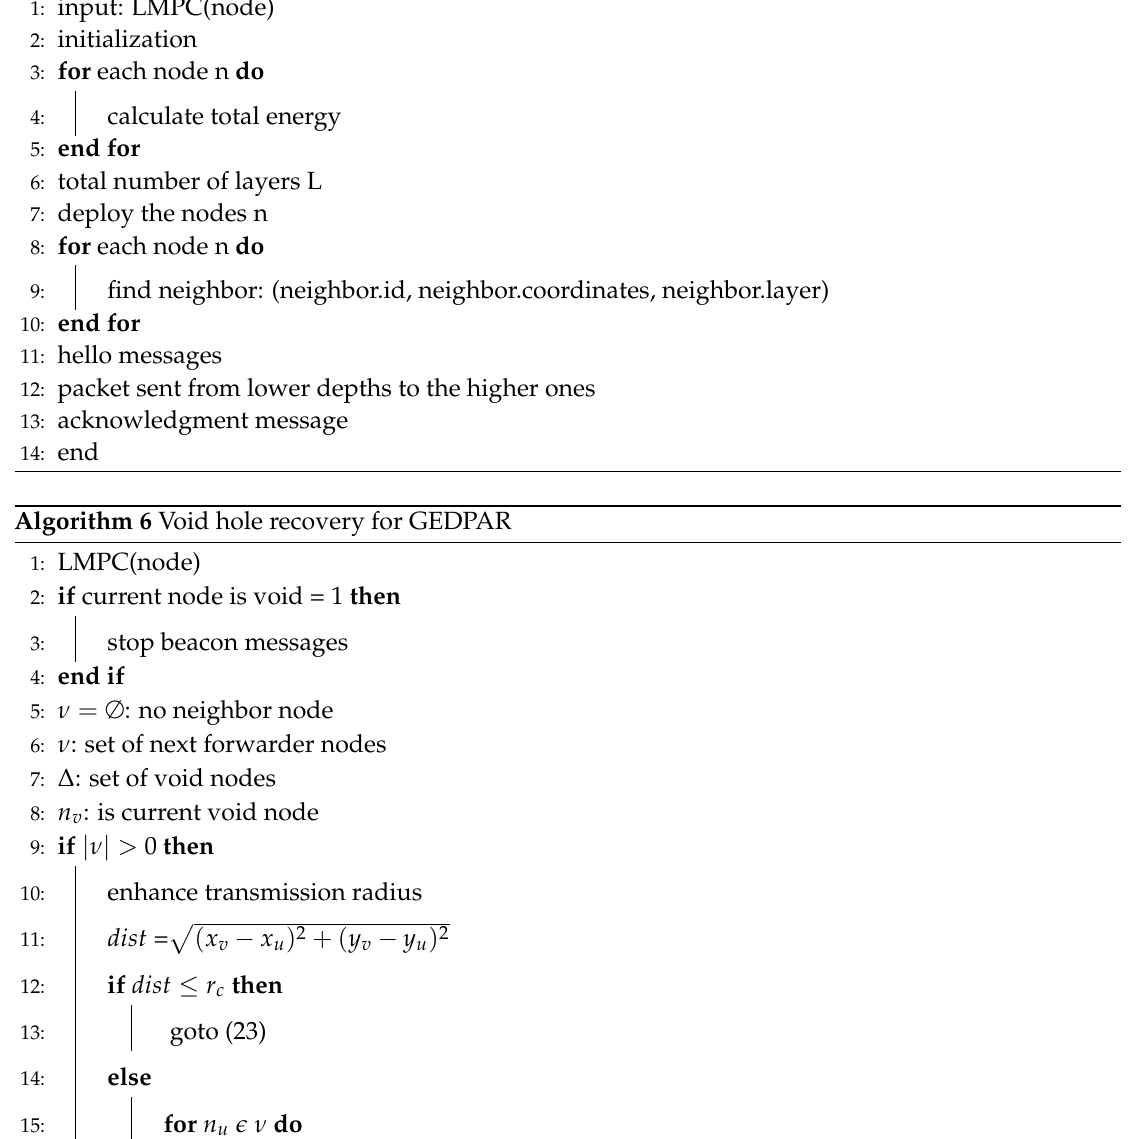
Algorithm 5 LMPC